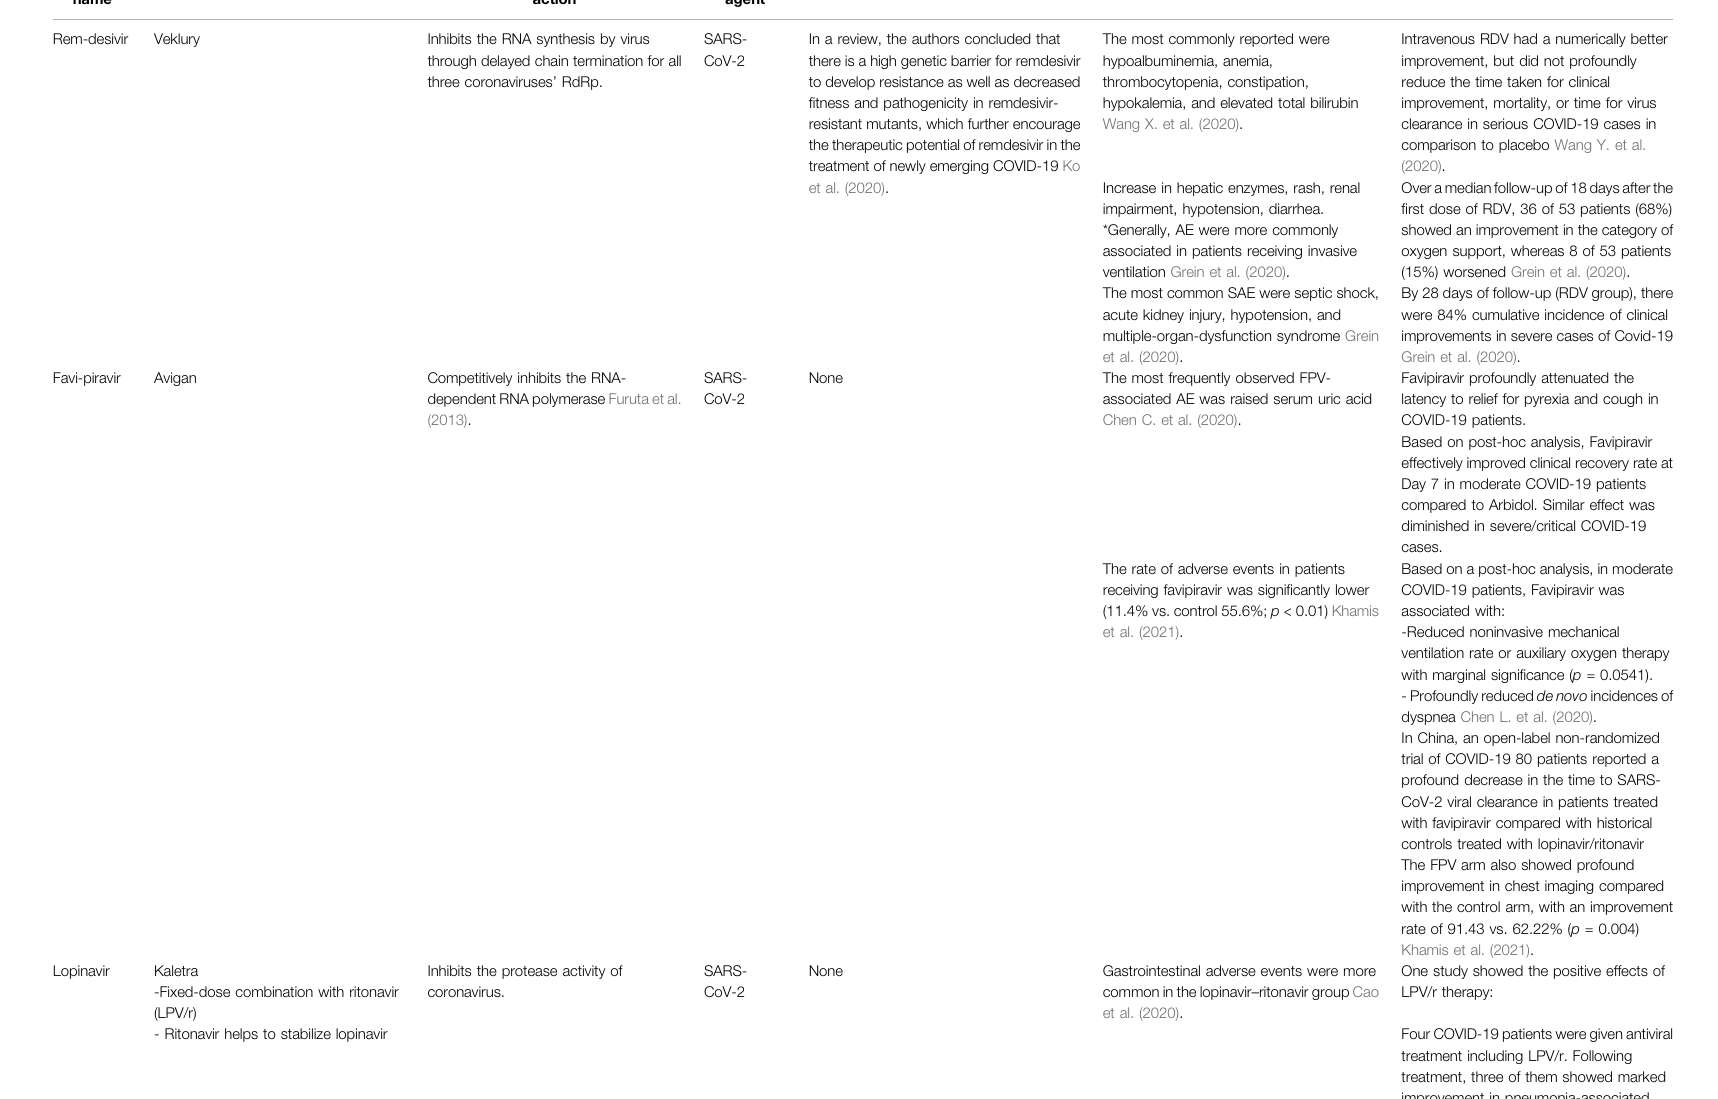
TABLE 2 | Antiviral medications for the treatment of SARS-CoV-2. Chemical